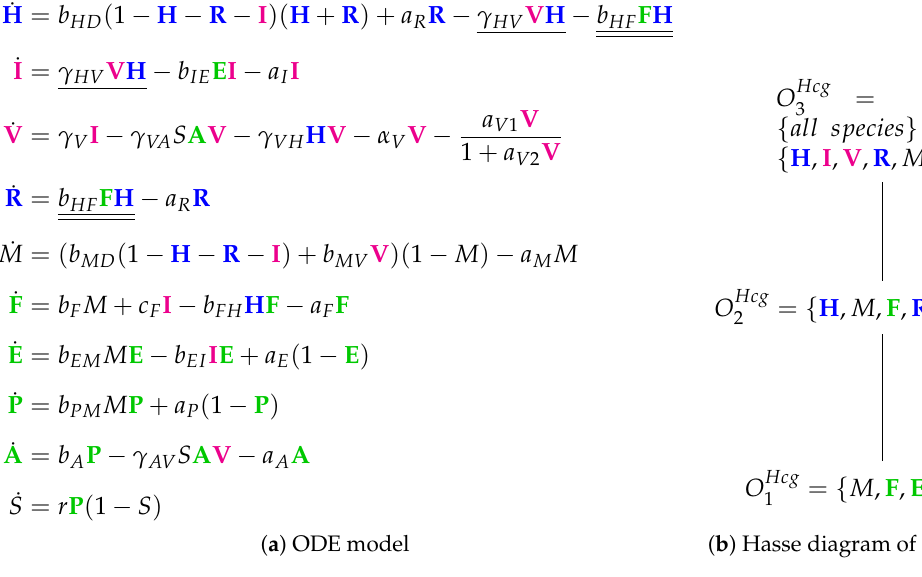
Figure 12. The Hancioglu Model [29] with 10 variables: viral load ( V ), healthy cells ( H ), infected cells ( I ), antigen presenting cells ( M ), interferon ( F ), resistant cells ( R ), effector cells ( E ), plasma cells ( P ), antibodies ( A ) and antigenic distance ( S